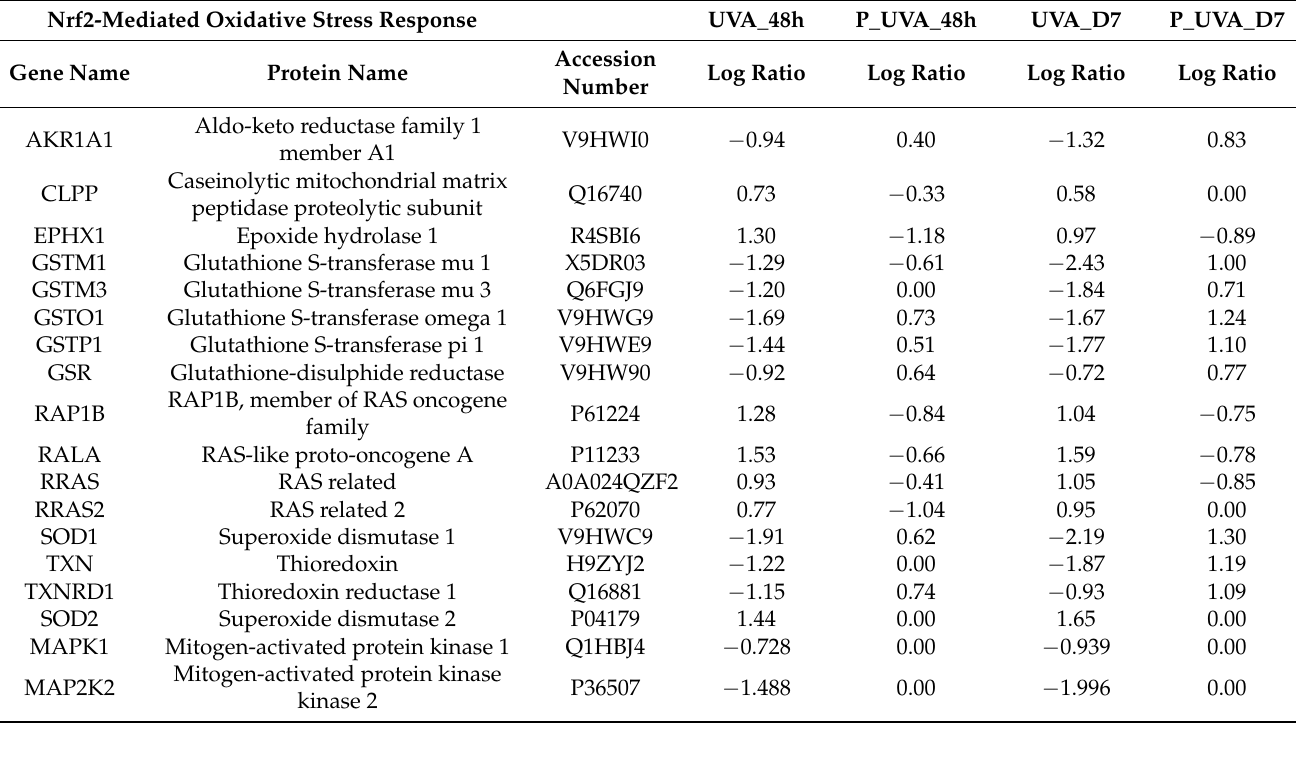
Table 4. Proteins involved in the Nrf2-mediated Oxidative Stress Response.